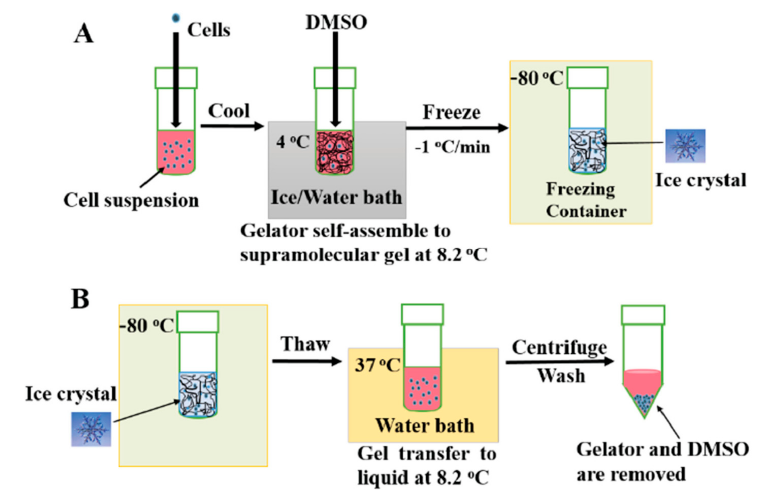
Figure 13. The ( a ) cooling and ( b ) warming processes of the supramolecular gel developed for minimizing cell damage during storage via cryopreservation by Zeng et al. [115]. Adapted with permission from ref [115]. Copyright 2015 John Wiley and Sons.